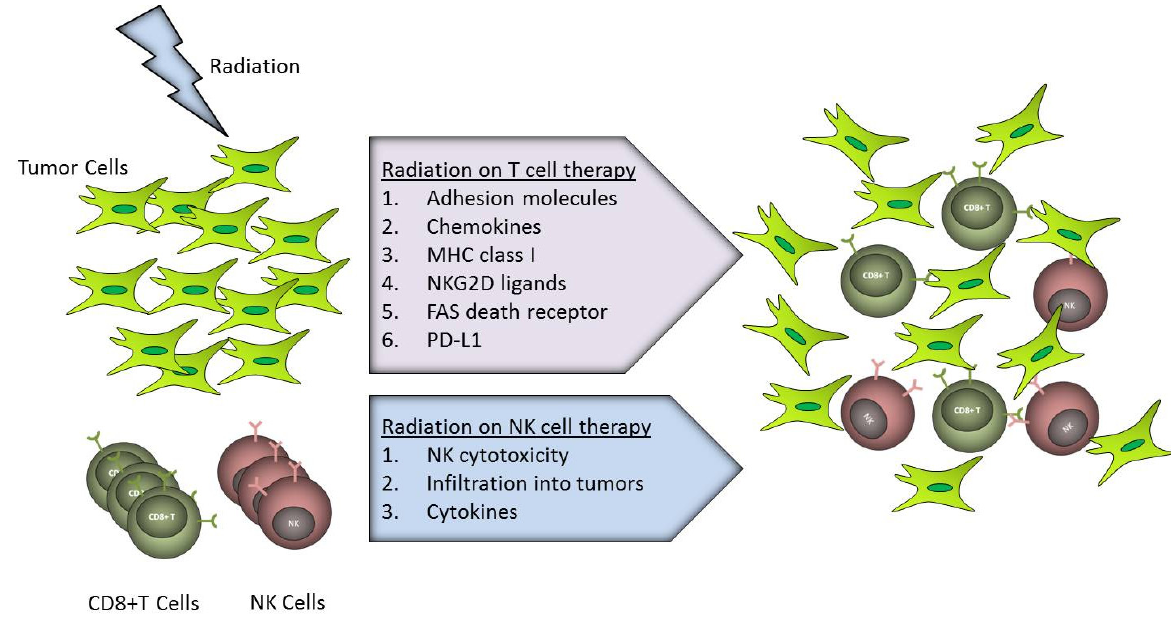
NKG2D ligands, FAS or PD-L1 on target cells upon irradiation. In case of NK